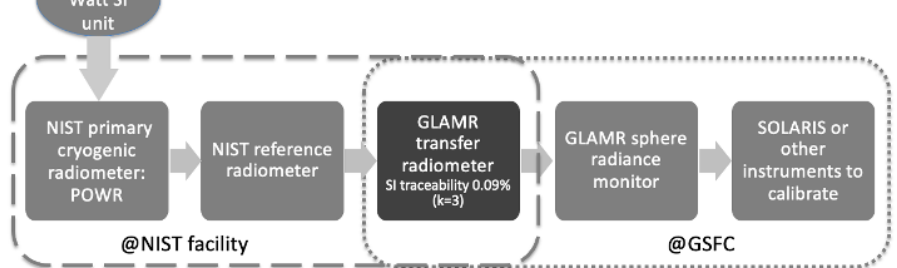
Figure 3. The traceability to SI units for the GLAMR radiometric